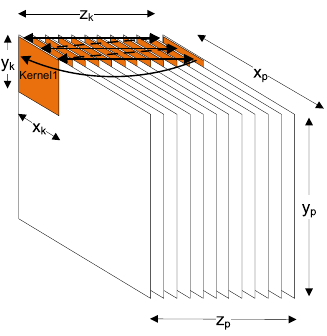
Figure 3. The convolution of a 3D kernel with the corresponding